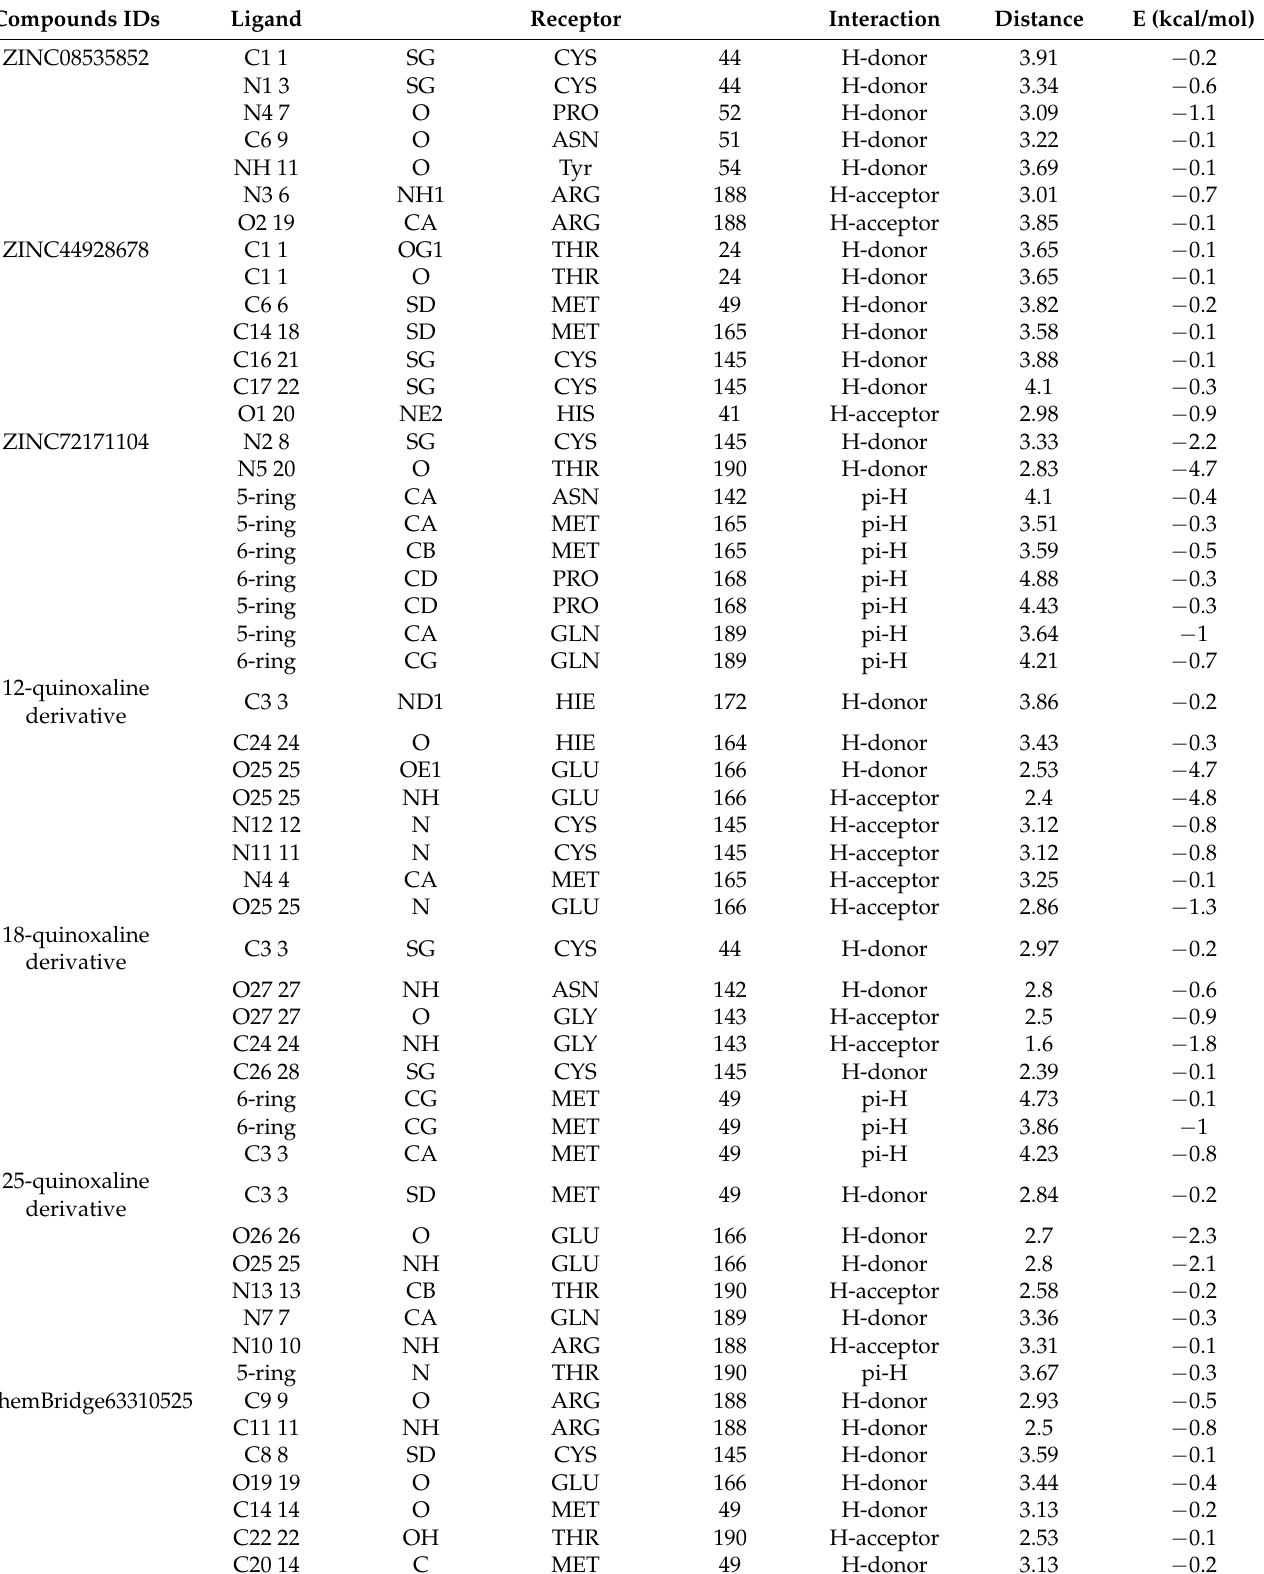
Table 2. Details of binding interactions against COVID-19 M pro